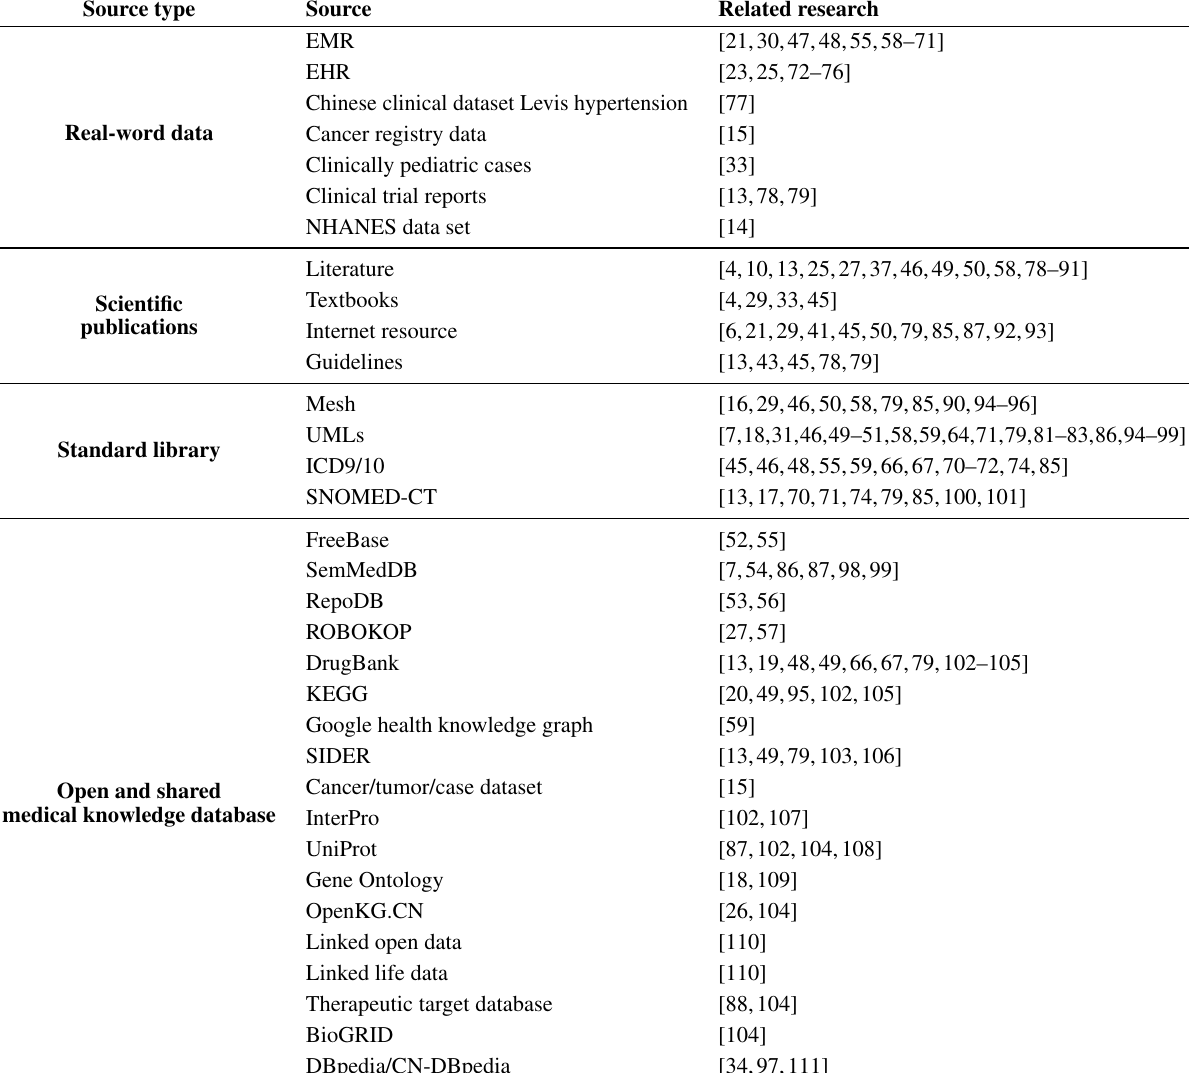
Table 1 Data sources of MKG and related